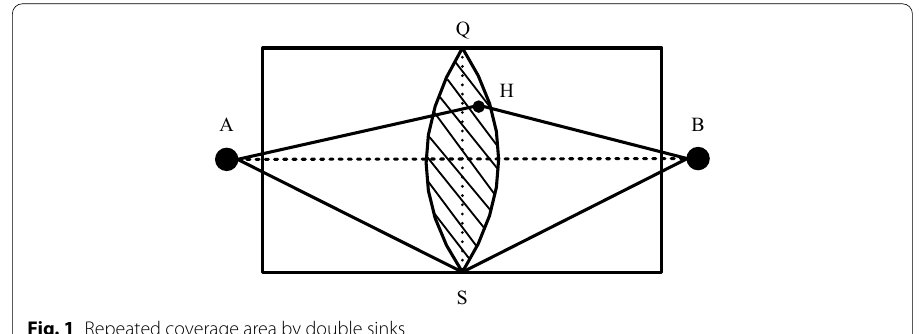
Fig. 1 Repeated coverage area by double